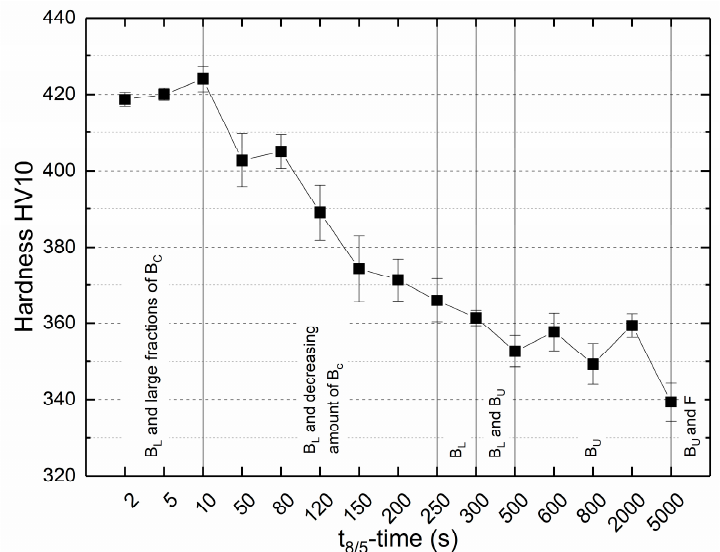
Figure 16. Vickers hardness as a function of the t 8 / 5 -time and the observed corresponding microstructure constituents lower bainite (B L ), coalesced bainite (B C ), upper bainite (B U ) and ferrite